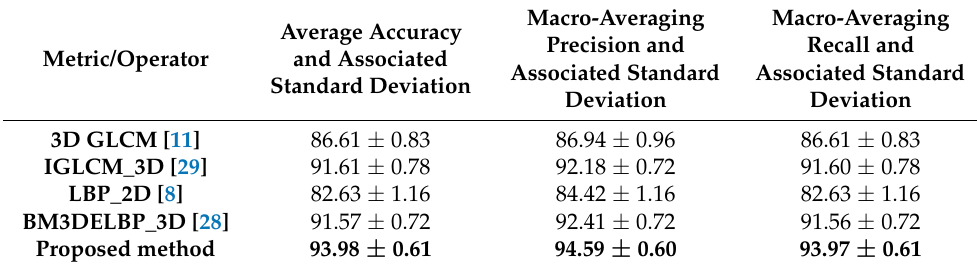
Table 8. Classification results for the second experiment with the kNN classifier [%].